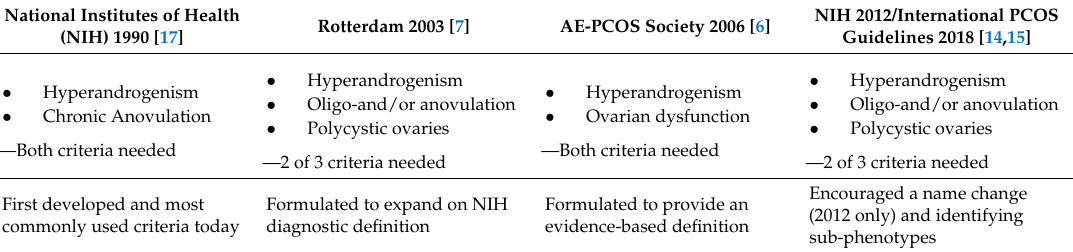
Table 1. Diagnostic criteria for polycystic ovarian syndrome